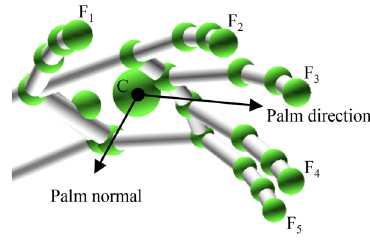
Figure 2. The hand model in the LMC.